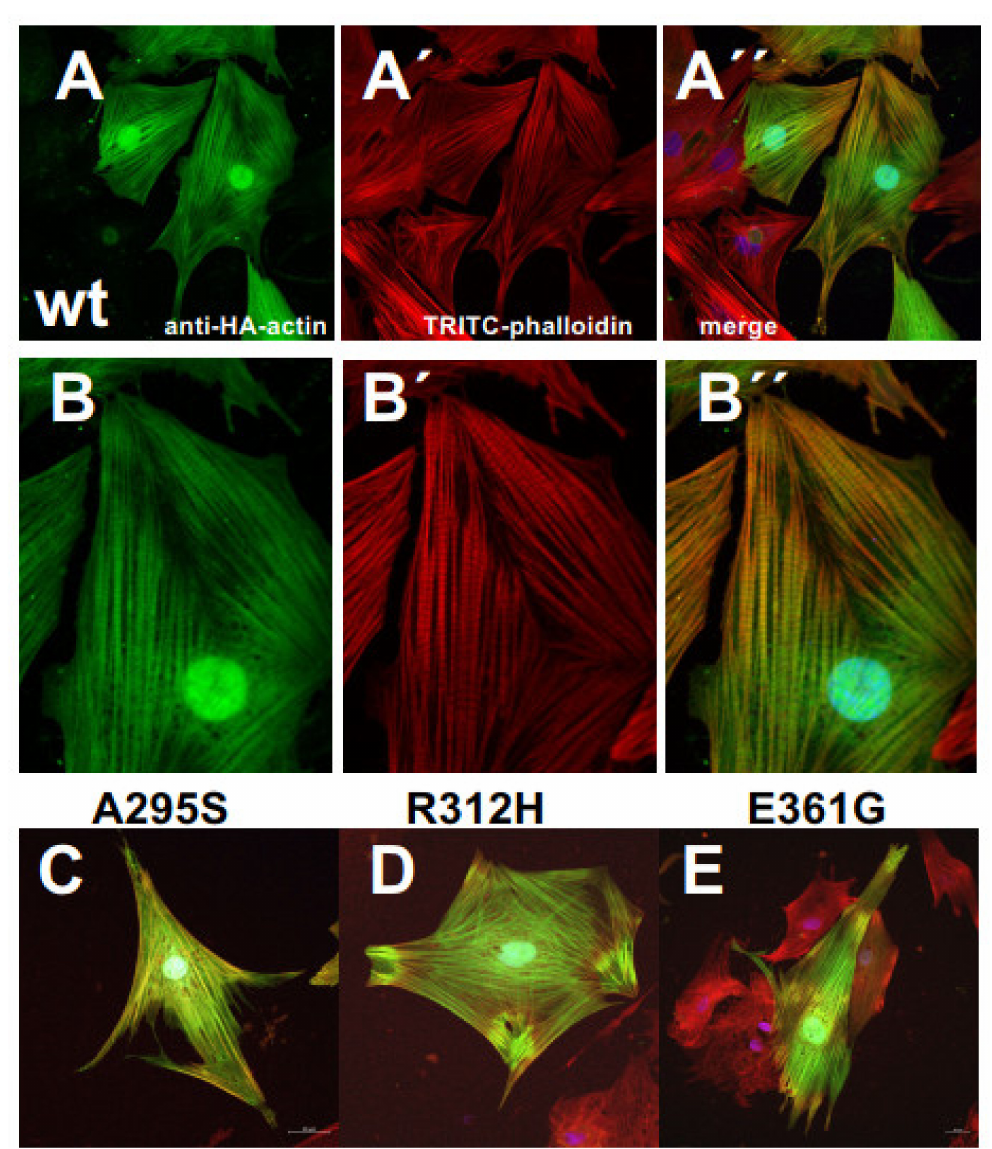
Figure 6. Neonatal rat cardiomyocytes (NRC) expressing HA-tagged c-actin variants. ( A , B ) Transduction of NRCs with adenoviral constructs encoding wt c-actin and subsequent immunostaining with anti-HA antibody (green), ( A’ , B’ ) TRITC- phalloidin (red), and ( A” , B” ) merged images also including nuclear staining with Hoechst 33342 (blue). ( B – B” ) Gives higher magnification of ( A – A” ) to visualize the cross-striation. ( C – E ) Merged images of NRCs expressing after transduction the p.A295S, R312H, and E361G mutants, respectively, stained by the identical procedure. Bars: 20 µ